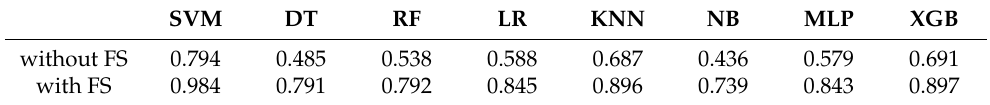
Table 7. Cohen’s Kappa results without and with feature